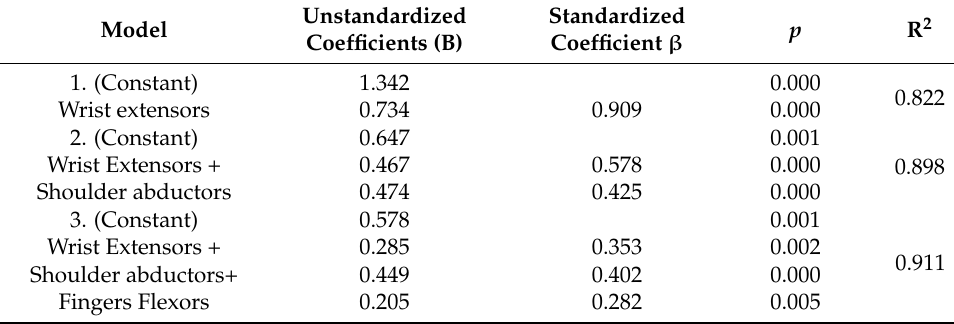
Table 6. Linear regression for assessing the UE